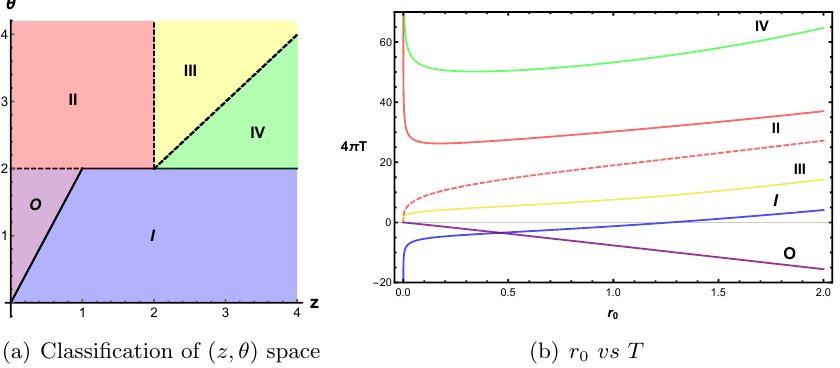
Figure 2 . Classi(cid:12)cation of ( z; (cid:18) ) space by T -range: each curves in (b) represent a typical curve of each region with the corresponding color of